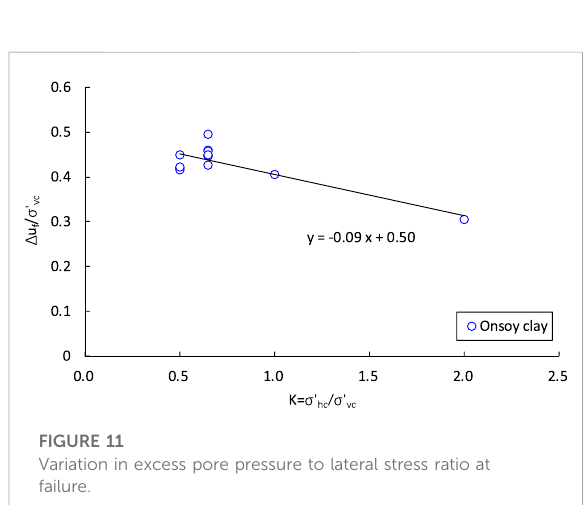
FIGURE 12 Variation in excess pore pressure and normalized shearing rate ratio at